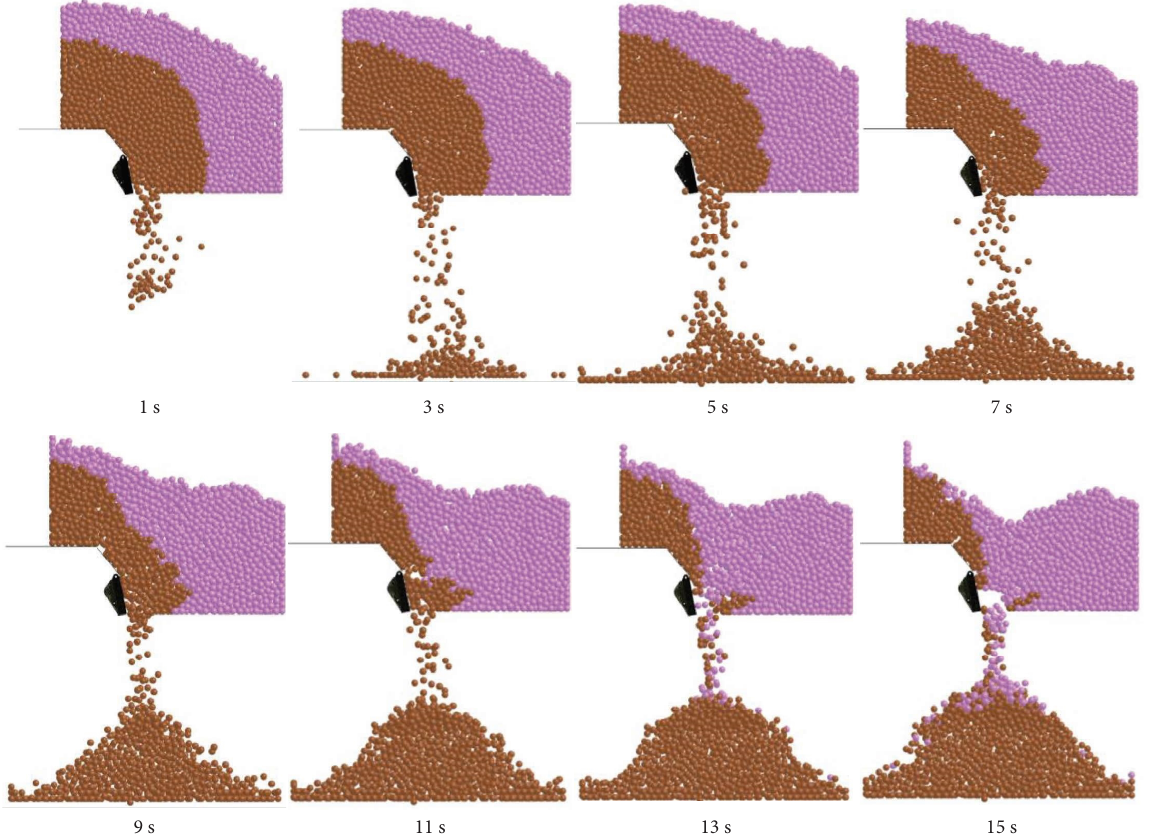
Figure 23: Te coal-caving process when the mining and caving ratio is